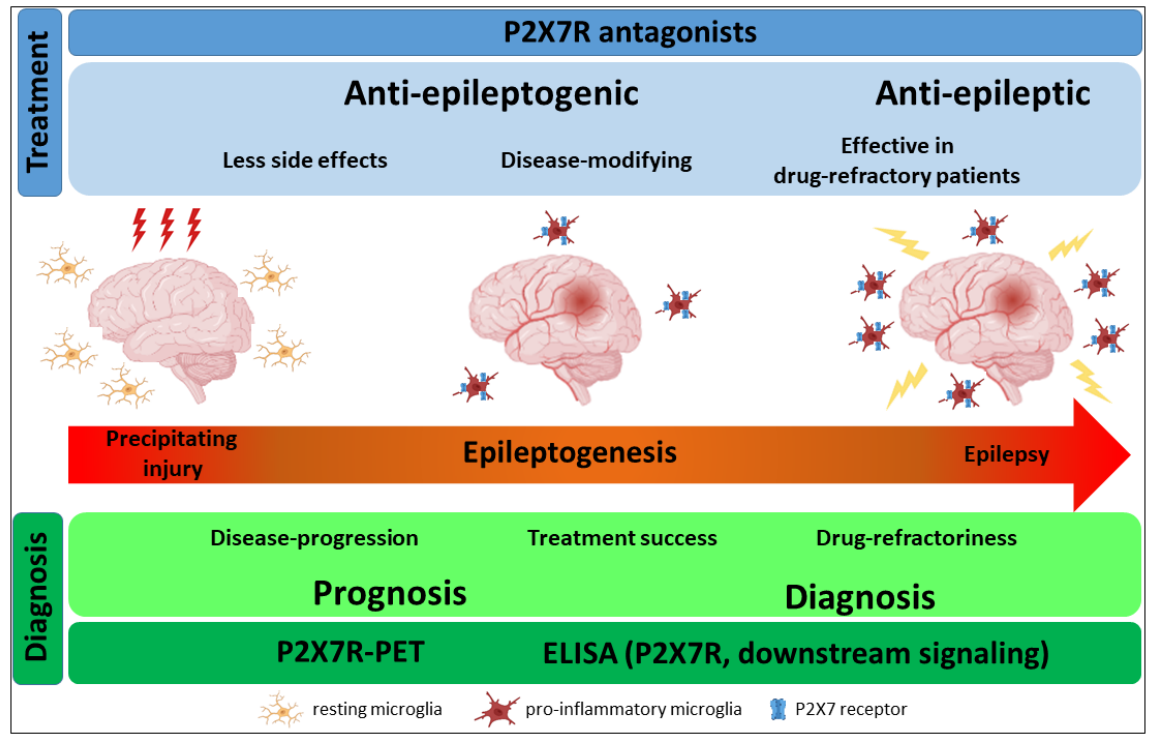
Figure 1. P2X7R as a therapeutic and diagnostic target for epilepsy. Following a precipitating injury to the brain, P2X7R expression increases on microglia where it promotes pro-inflammatory signalling, thereby contributing to increased brain hyperexcitability and epilepsy development. P2X7R antagonism mitigates the development of epilepsy and suppresses seizures during epilepsy, possibly leading to disease modification. Diagnostic tools based on P2X7R include P2X7R radiotracers and assays to measure P2X7R plasma concentrations and P2X7R downstream signalling molecules.